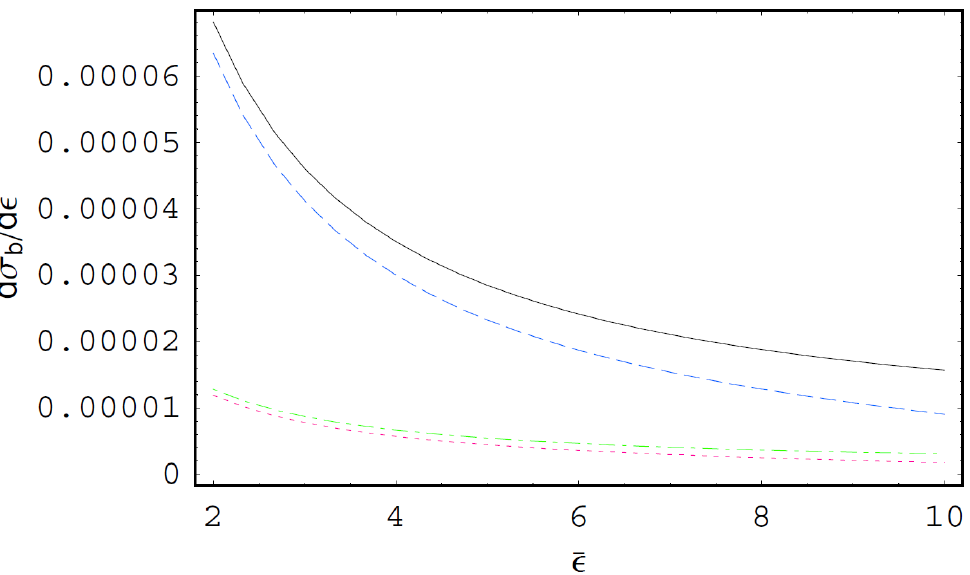
15 E = . The black solid line is the Coulomb focused electron–atom bremsstrahlung atoms when 0 Figure 2. The scaled form of the electron–atom bremsstrahlung cross section ( d σ b / d ε ) Figure 2. The scaled form of the electron–atom bremsstrahlung cross section ( / ) d d σ ε cross section ( / ) CF energy in units of π a 2 / Ry as a function of the scaled photon energy ε for W and Fe atoms when E 0 = 15. − for the W atom including the influence of Coulomb focusing. The blue b e a 0 / a Ry π as a function of the scaled photon energy ε for W and Fe photon energy in units of 2